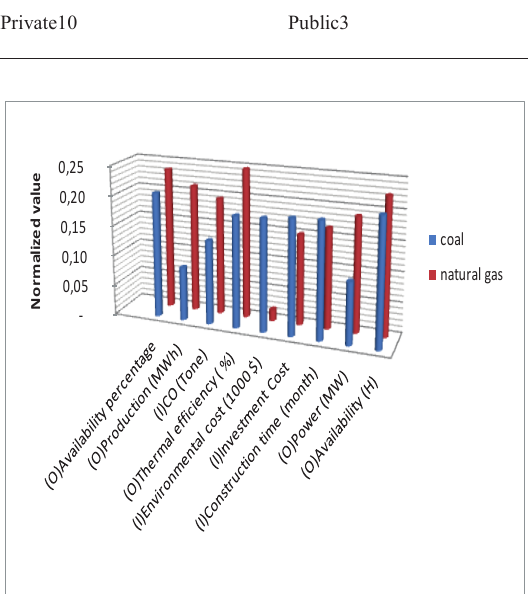
Fig. 1. Comparison of coal - based and natural gas - based power plants Another comparison is made between public versus private coal based and natural gas based power plants as given in Figure 2 and Figure 3.